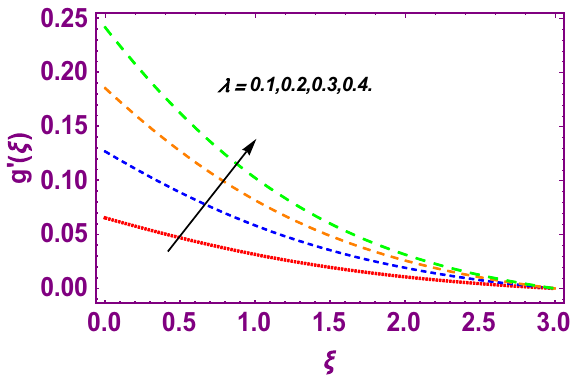
Figure 7. Effect of (cid:31) on g ′ (ξ) .